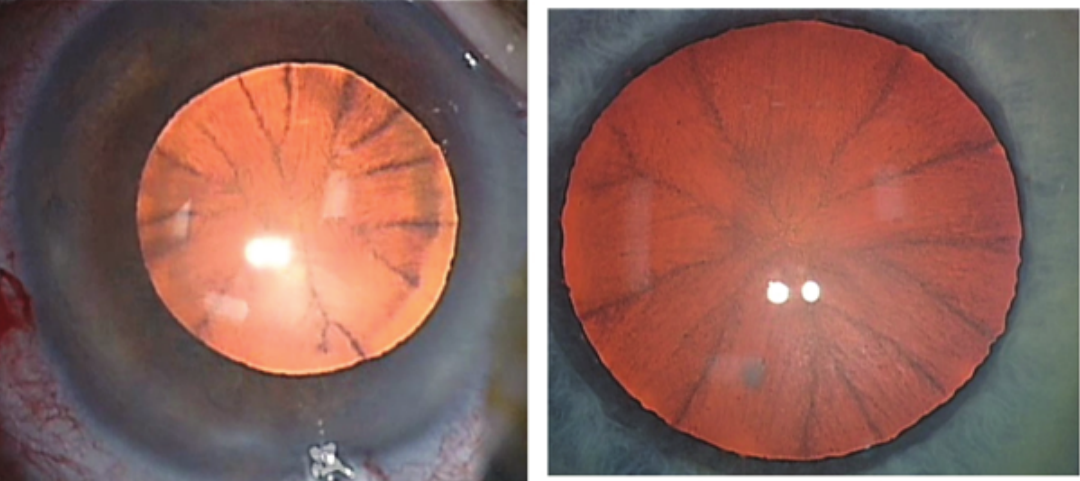
Figure 2. Early (left) and late (right) staining of the crystalline lens following intracameral use of phenylephrine hydrochloride in two different